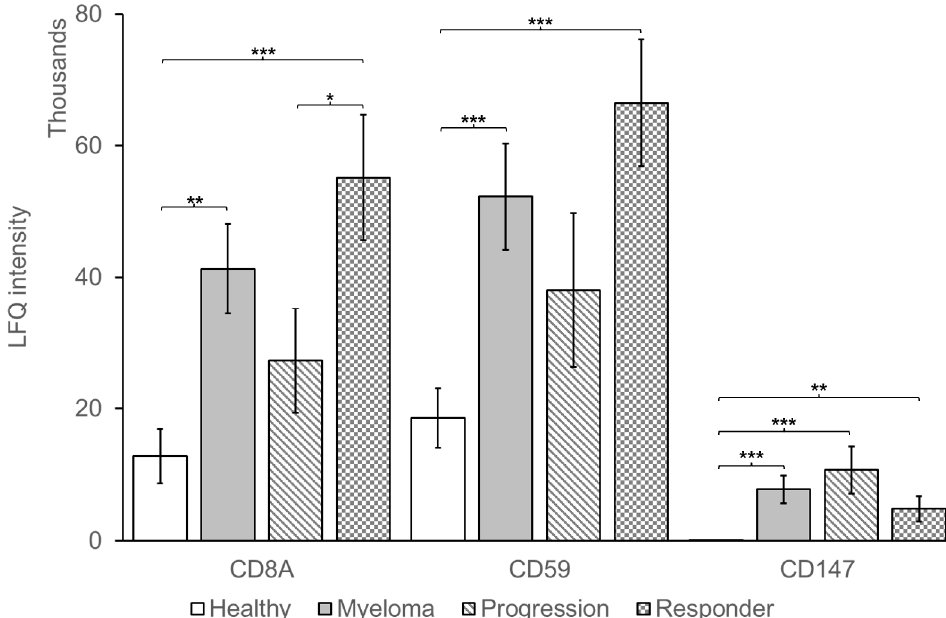
Figure 6. Differentially regulated proteins identified in multiple myeloma patient plasma EVs relative to healthy patient plasma EVs by LC-MS/MS. 2.5 × 10 8 EV isolates from 10 MM patients (5 responders and 5 patients progressing on DARA) and 10 healthy controls were resuspended in 6 M urea, 50 mM Tris-HCl, reduced and alkylated using dithiothreitol and iodoacetamide. Following trypsin digestion each sample analyzed in duplicate on a Bruker timsTof Pro mass spectrometer connected to an Evosep One liquid chromatography system. Error bars refer to standard error of the mean (* p < 0.05, ** p < 0.01 and *** p < 0.001 by two-tailed unpaired Student’s t